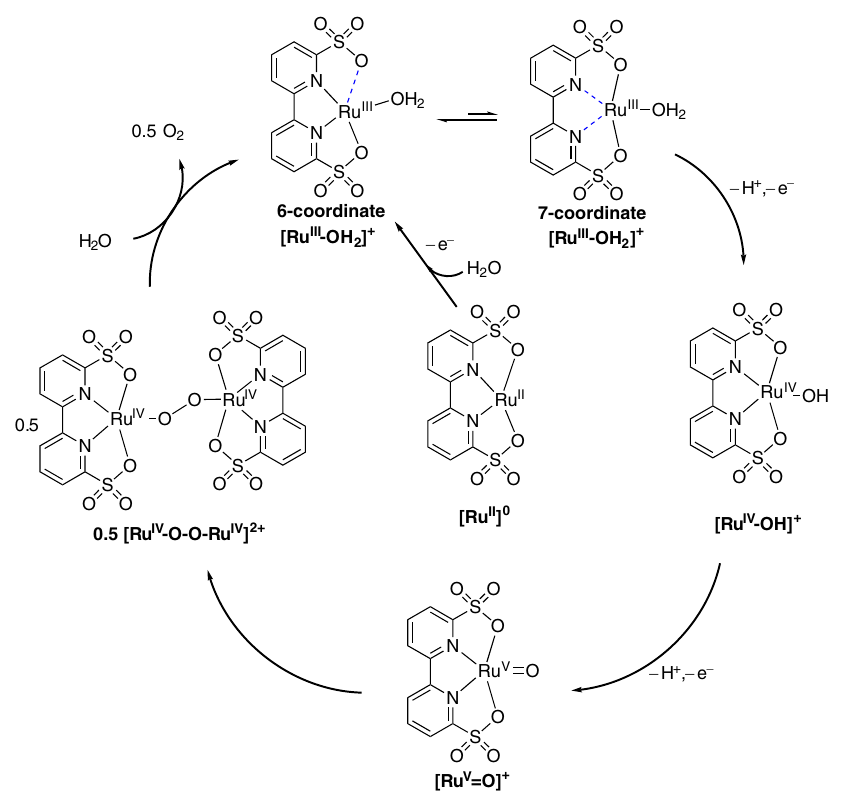
Fig. 7 Proposed mechanism. Proposed electrochemical driven water oxidation and O − O bond formation pathway by Ru-bds under the acidic conditions.